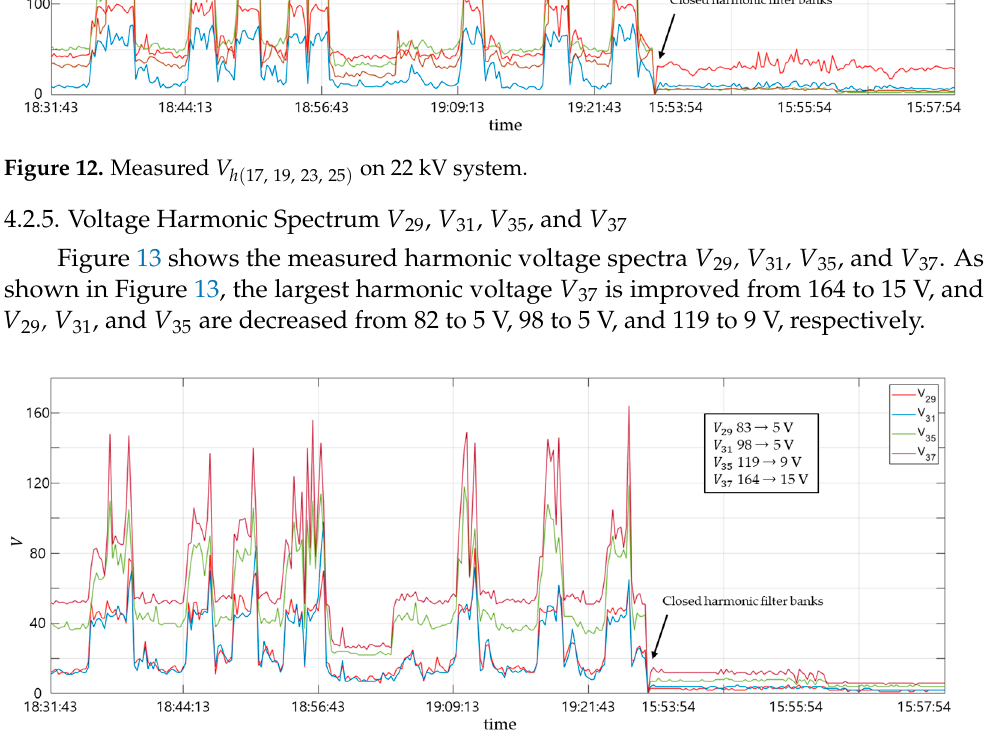
Figure 13. Measured V h ( 29, 31, 35, 37 ) on 22 kV system.